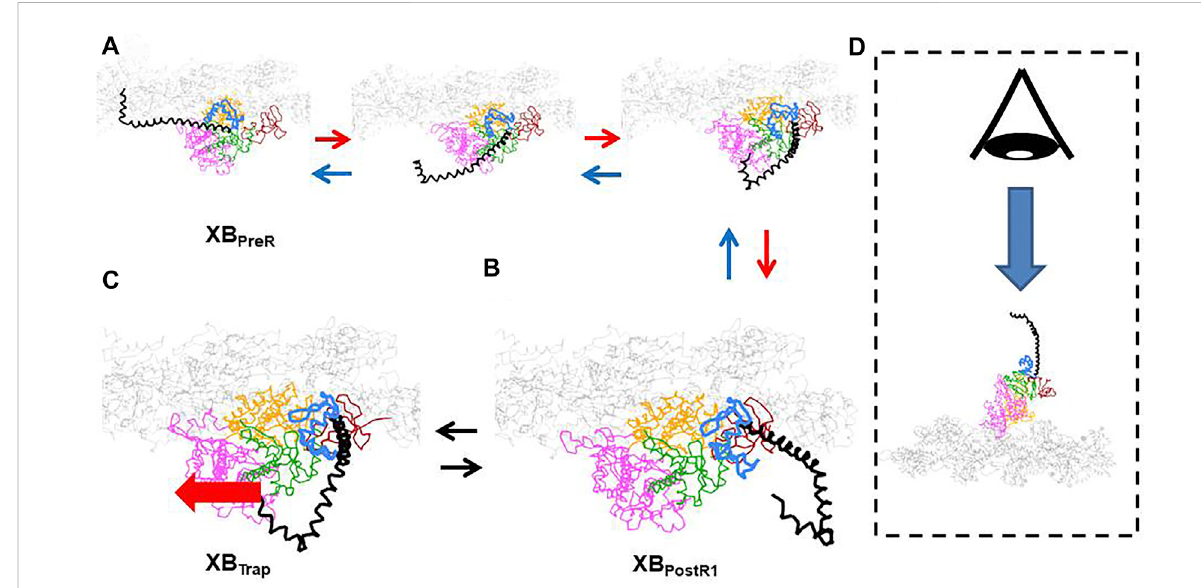
FIGURE 3 The conformation change of the myosin molecule in the fi rst power stroke transition. (A) Intermediate conformations between the XB PreR and XB PostR1 states. (B) Conformation in the XB PostR1 states (C) A candidate of conformation of the XB Trap state with the imposed pulling force (thick red arrow). (D) The viewpoint for (A – C) . The myosin molecule is divided into the following domains: lever arm (black), converter (light blue), N-terminal (brown), central domain (green), upper 50 k (pink),and lower 50 k (orange). The thin fi lament iscoloredgray. In theXB Trap state, theleverarm is trapped in the V-shaped region of the converter. The rotation of the converter might be inhibited in the case of a strong pulling